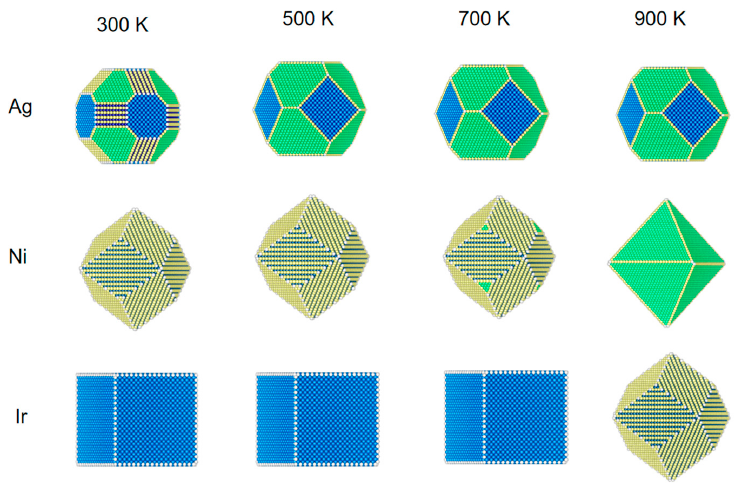
Figure 3. The structural evolution of 5 nm metal NPs (Ag, Ni, and Ir) at different temperatures and 1 bar of CO.